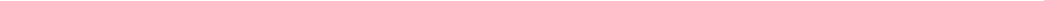
Figure 1: Organ procurement steps and ischaemia times in cDCD when organs are retrieved by the rapid cold preservation technique (in short, rapid procurement). Adapted DCD Scheme of the Steering Committee of the National Committee for Organ Donation 2019. a Heparin administration at t0, 300 IU/kg iv. If the likelihood of mortality is low and/or there is an increased risk of bleeding, the attending ICU physician may decide to administer the heparin later but no later than at t1. b The following mean arterial pressure (MAP) values are to be used, depend- ing on age category: 0 to 1 year: <35 mm Hg; 1 to 3 years: <40 mm Hg; 3 to 5 years: <45 mm Hg; 5 years and above: <50 mm Hg (for a mini- mum of 2 minutes). c According to the Swiss Academy of Medical Sciences [18]. d Process may be stopped earlier if after 60 minutes from t0 none of the three criteria are met: pH <7.2; systolic blood pressure <70 mm Hg; SpO 2